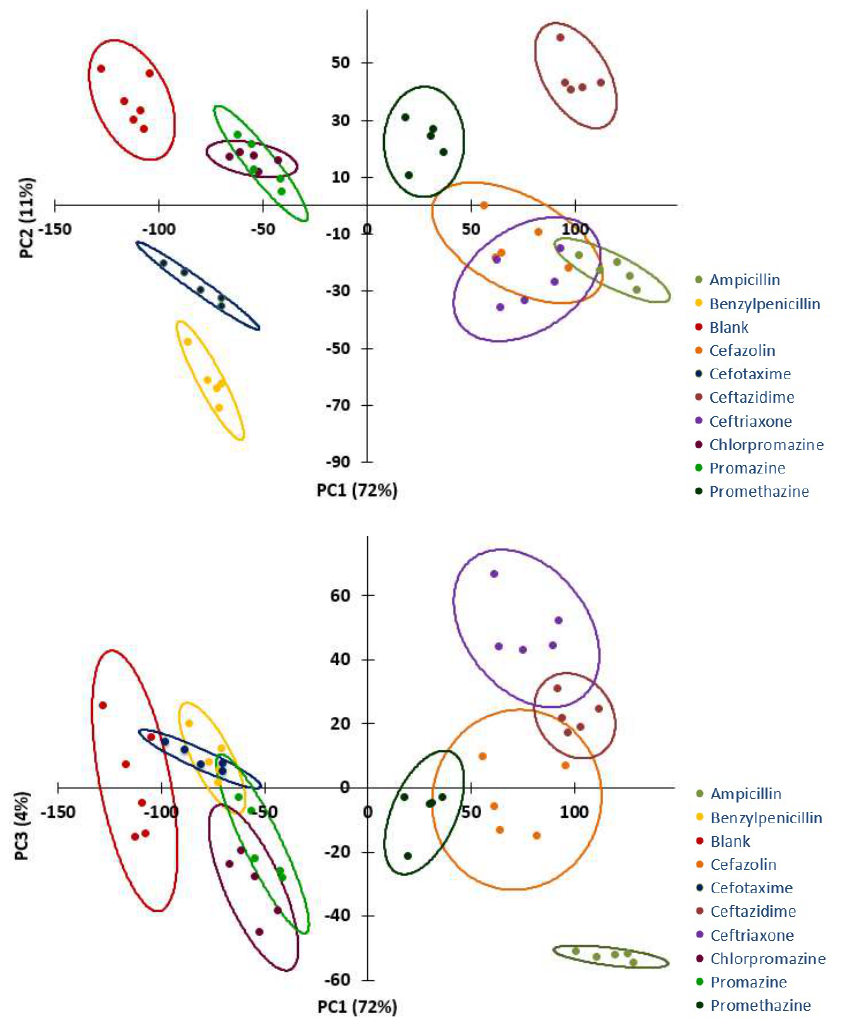
Figure 7. Score plots in PC1–PC2 and PC1–PC3 coordinates obtained with the basic dataset for the indicator reactions conducted in the presence of turkey meat